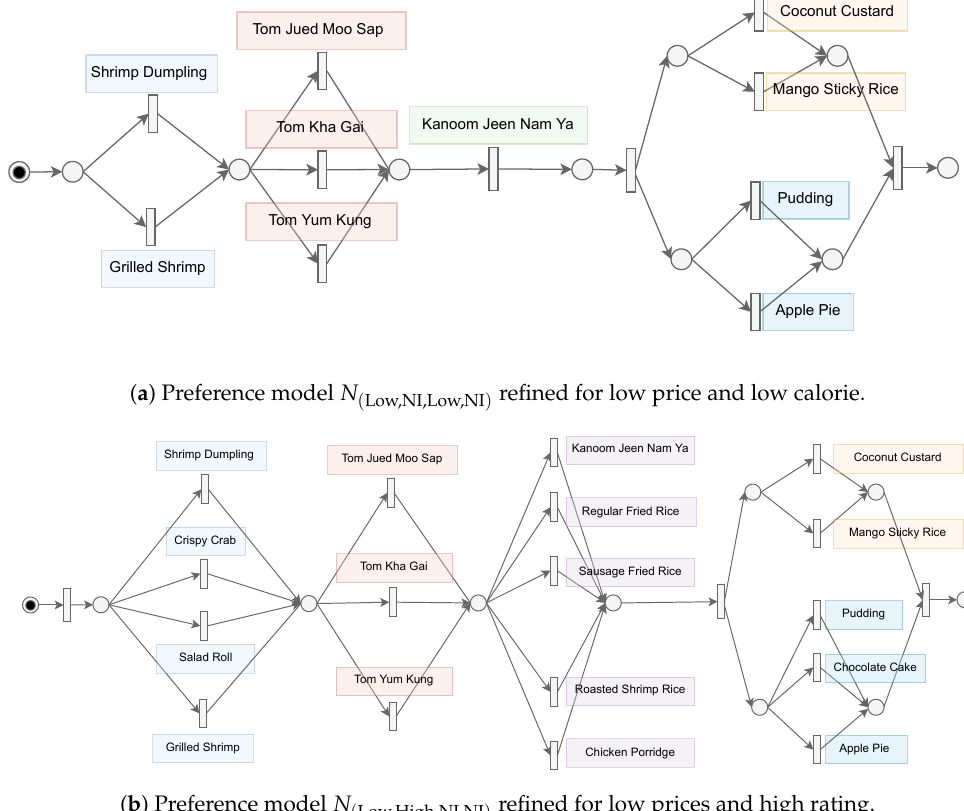
Figure 8. Implicit preference models output by Procedure